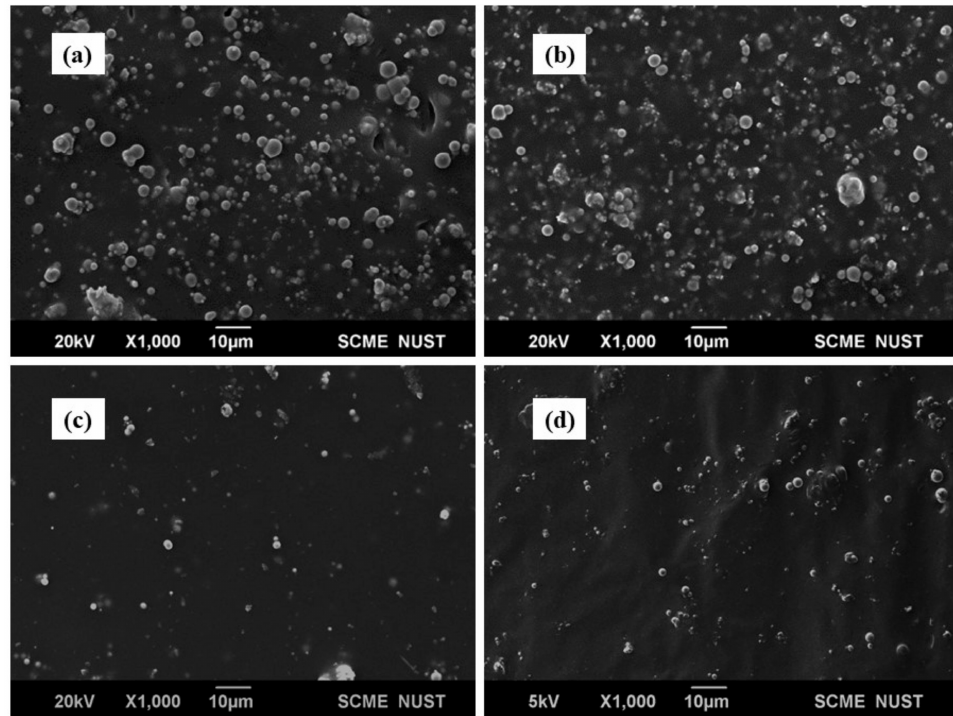
Figure 3. SEM images for MR Elastomers ( a ) 40% Ni-Fe ( b ) 40% Co-Fe ( c ) 10% Ni-Fe ( d ) 10% Co-Fe.